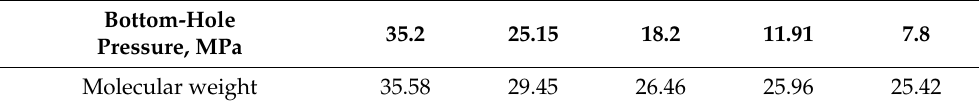
Table 4. Molecular weight of produced fluid in the bottom hole in the gas reservoir. Bottom-Hole